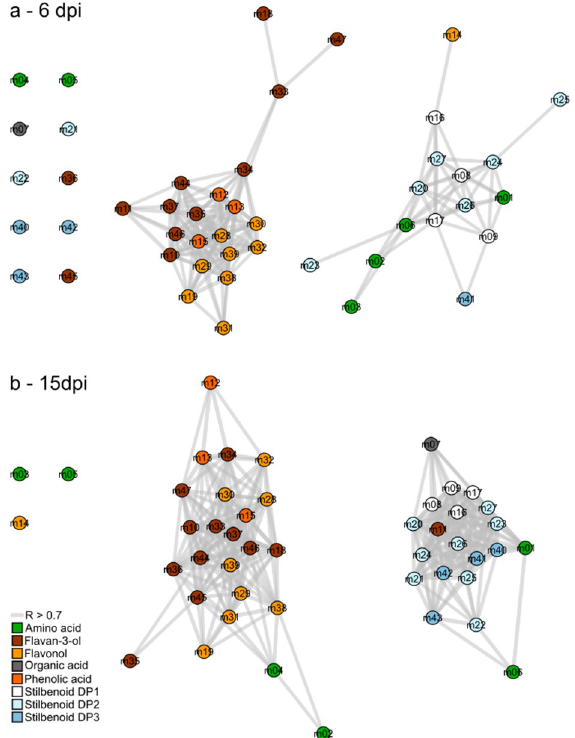
Figure 3. Correlation-based networks of metabolism from leaves of Vitis vinifera L. cv. Malbec upon downy mildew infection at 6 ( a ) and 15 dpi ( b ). Nodes numbers refers to the ID presented in Table 1 and edges to significant correlation of metabolite pairs (threshold: R > 0.7 and p -value < 0.05).